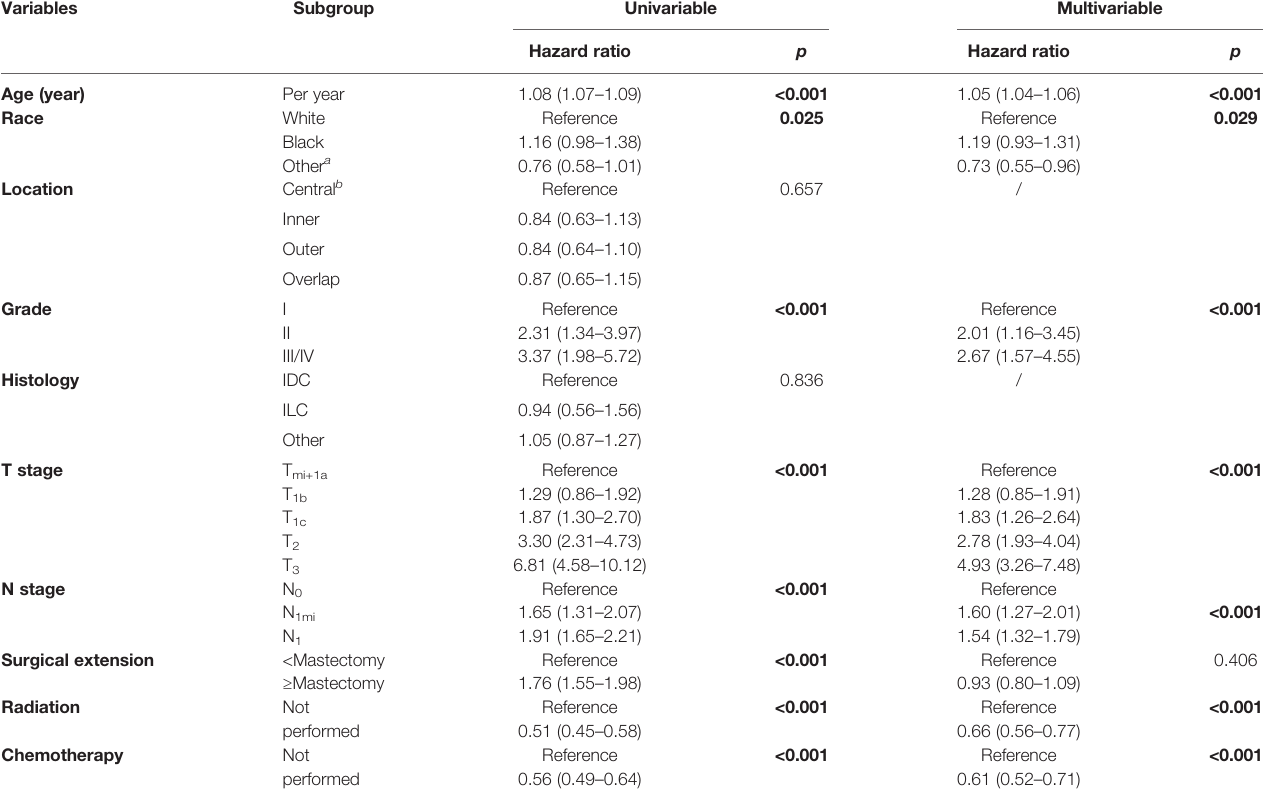
TABLE 2 | Univariate and multivariate Cox regression analyses of predictive variables correlated with OS in elderly primary operable TNBC patients ( ≥ 70 years old).